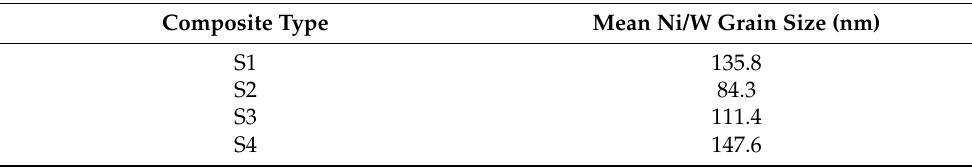
Table 3. Average Ni-W sizes of Ni/W-SiC nanocomposites.